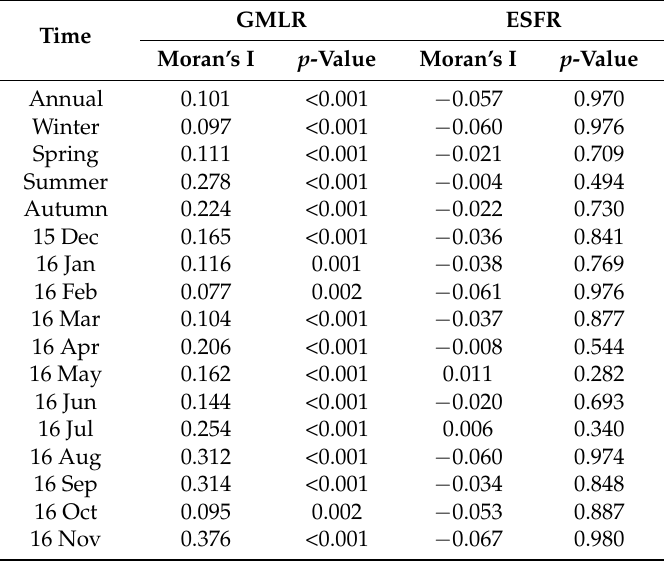
Table 8. Residual Moran’s I of annual, seasonal and monthly models.